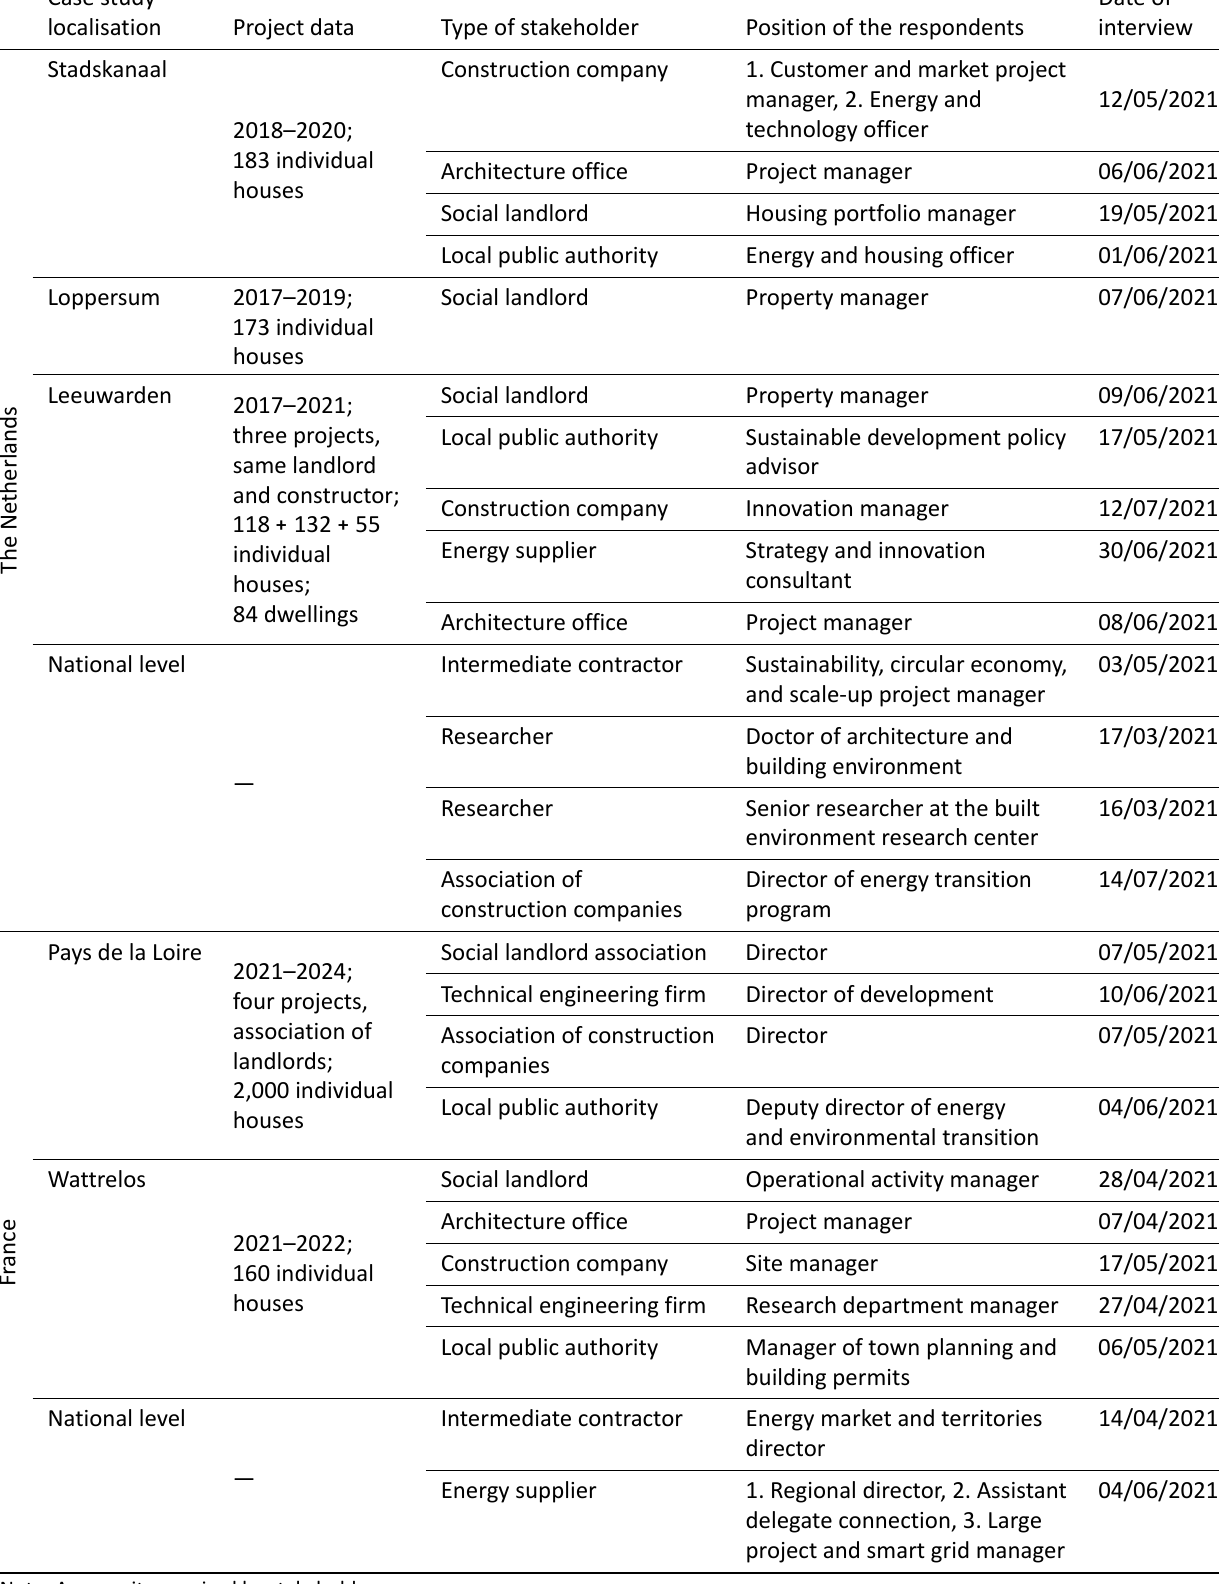
Table 1. Body of interviews used for this